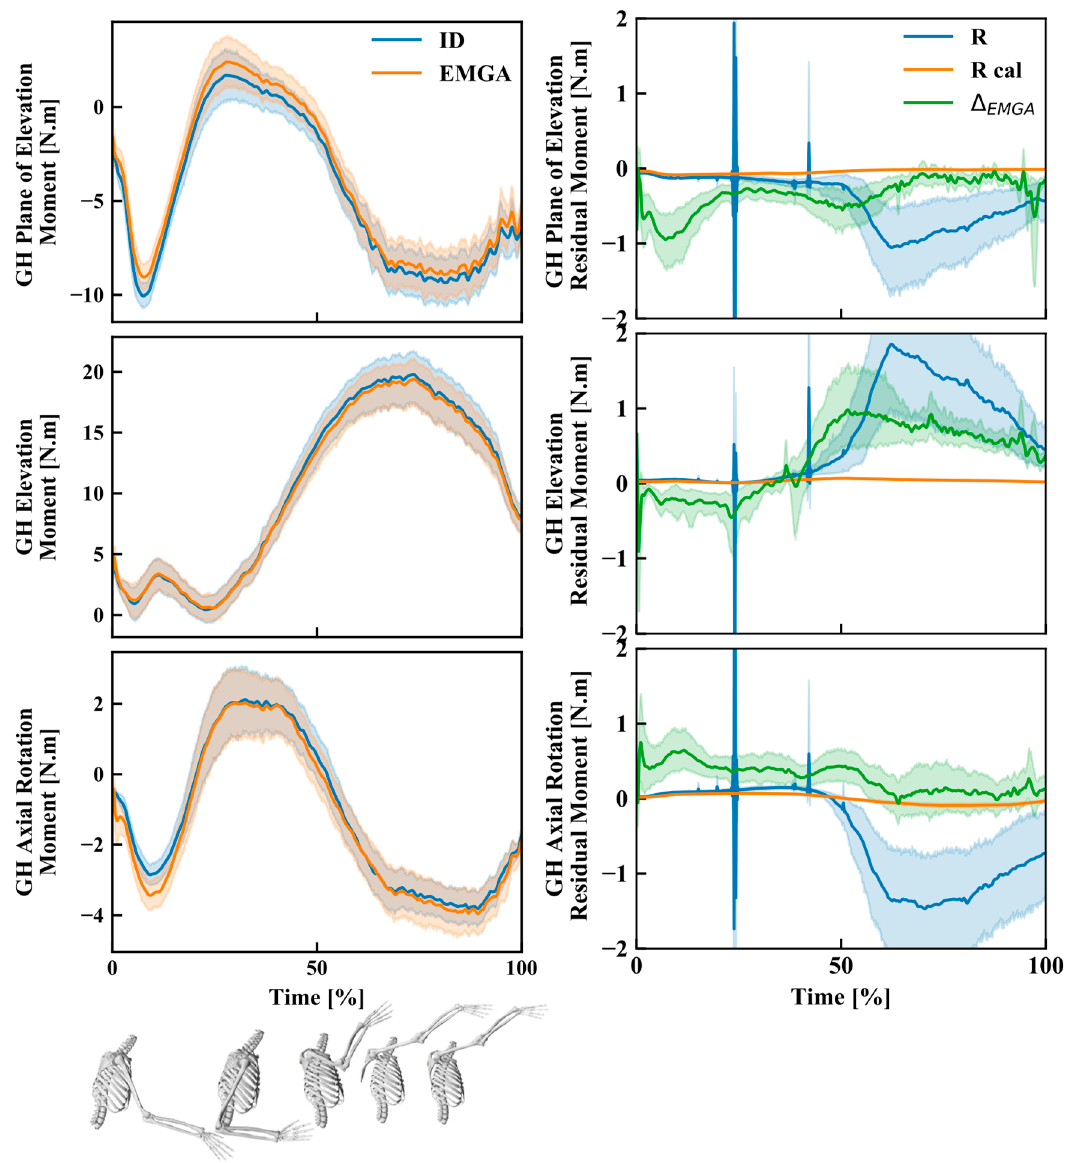
Figure 1. Left : Net moments of the GH joint calculated by inverse dynamics (ID in blue) and predicted with the EMG-assisted method (EMGA orange), with a schematic of various position of the participant during the box lifting task, right : residual actuators from the generic model (R in blue), calibrated model (R cal in orange), and the difference between the inverse dynamics and the net moments predicted with the EMG-assisted method ( ∆ EMGA in green). (solid line: mean value, shaded region: 95% confidence interval). Table 1. RMSd and R between the GH net moment calculated by inverse dynamics and those predicted by the EMG-assisted method, compared to the root mean squared sum of the residual actuators. Mass (kg) GH DOF RMSd (N.m) Residual Actuators (N.m) R